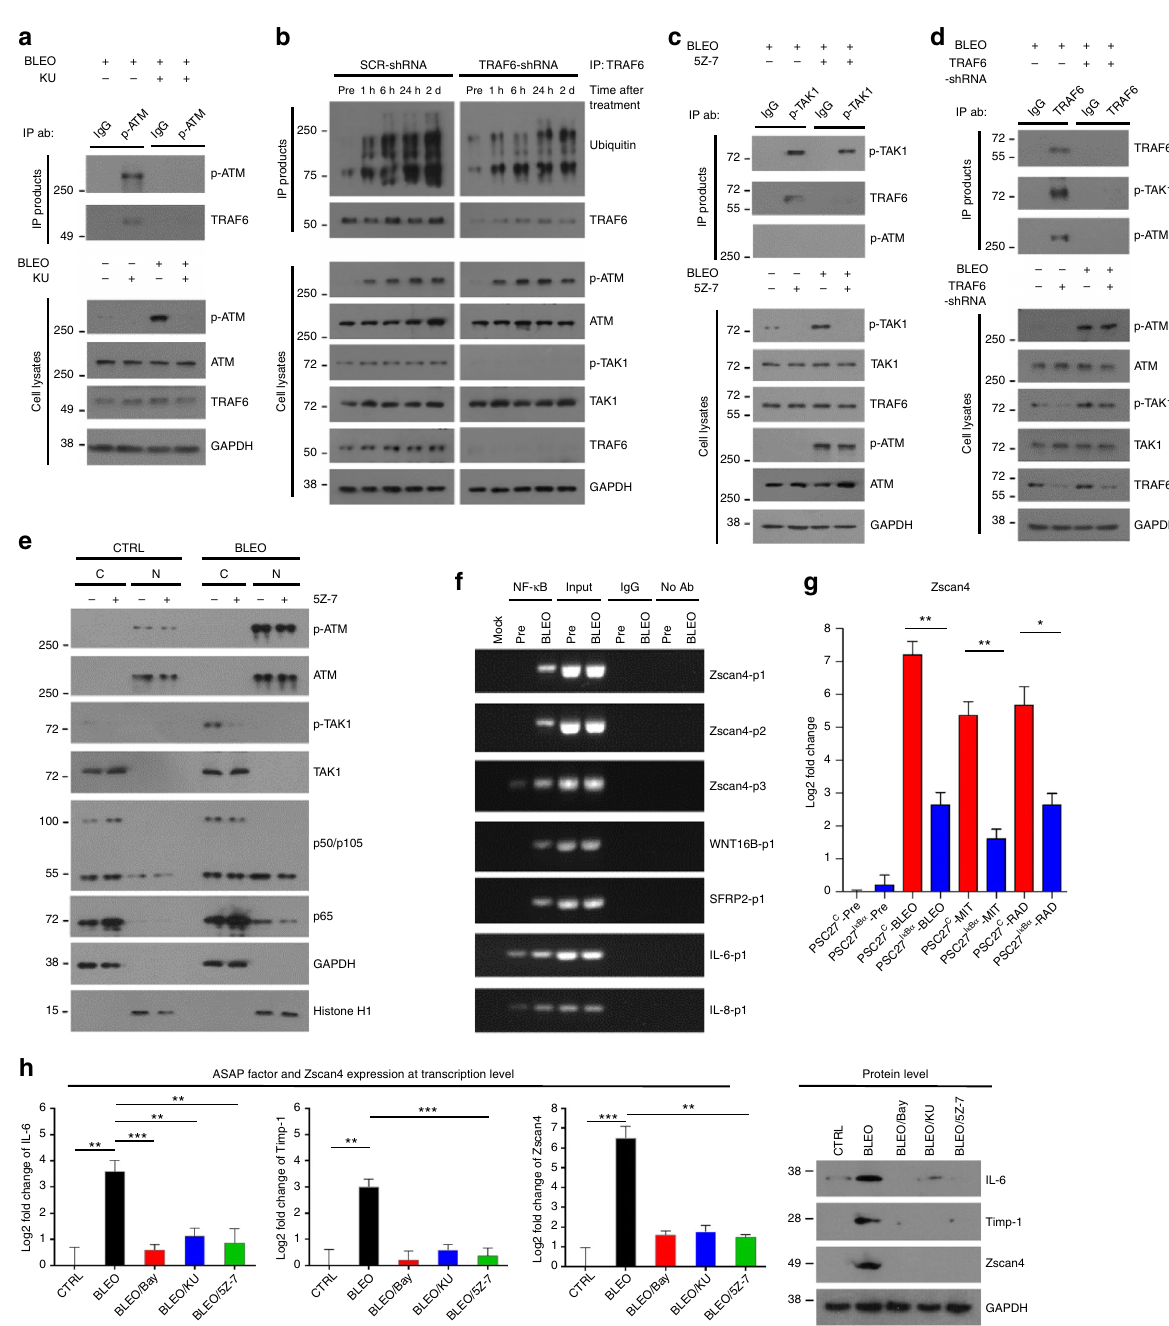
Fig. 4 Zscan4 expression is induced by DNA damage and regulated by the ATM/TRAF6/TAK1/p65 signaling axis. a PSC27 cells were treated by bleomycin (50 μ g/ml) with or without KU55933 (KU, 10 μ M) in culture. Cell lysates were immunoprecipitated with anti-p-ATM, with the immunoprecipitates (IPs) analyzed with anti-p-ATM and anti-TRAF6, respectively. b PSC27 cells lentivirally infected with scramble or TRAF6-speci fi c shRNAs were treated with bleomycin, with lysates collected at indicated time points and subject to IP and immunoblot assays. c Anti-TAK1-based IP of PSC27 cells treated with bleomycin in the presence or absence of 5Z-7 (500nM), followed by immunoblot analysis. d Primary PSC27 cells or those stably expressing shRNA to TRAF6 were treated with bleomycin, with IPs pulled down by anti-TRAF6 and examined by immunoblots. e Cytoplasmic and nuclear protein samples from control and bleomycin-treated PSC27 cells were analyzed for TAK1 activation and NF- κ B nuclear translocation. GAPDH and Histone H1, cytoplasmic and nuclear loading controls, respectively. f Chromatin immunoprecipitation (ChIP) was performed to identify potential NF- κ B binding sites in Zscan4 proximal promoter. Zscan4- p1/p2/p3 denotes 3 representative genomic sites in promoter region, with known NF- κ B binding sites from WNT16B, SFRP2, IL-6, and IL-8 selected as positive controls. g Zscan4 transcript expression in PSC27 cells stably expressing an NF- κ B-null mutant and treated by bleomycin, mitoxantrone or radiation. Signals normalized to untreated cells. h Expression pro fi ling of typical ASAP factors (IL-6/Timp-1) and Zscan4 in stromal cells exposed to bleomycin. Left (histograms), cells were pretreated with inhibitors of NF- κ B, ATM, or TAK1 (Bay, KU or 5Z-7, respectively) before addition of bleomycin, with transcripts collected for analysis 24h after genotoxic treatment (data normalized to untreated sample per factor set). Right (immunoblots), protein level assessment of IL-6, Timp-1, and Zscan4 24h after cell exposure to bleomycin. GAPDH, loading control. Data in all bar plots are shown as mean±SD and representative of 3 biological replicates. BLEO bleomycin, KU KU55933, 5Z-7 5 Z -7-oxozeaenol, Bay Bay 11 – 7082. Data in g , h were analyzed by Student ’ s t -test. * P <0.0 5 , ** P <0.01, *** P <0.001, ^ P